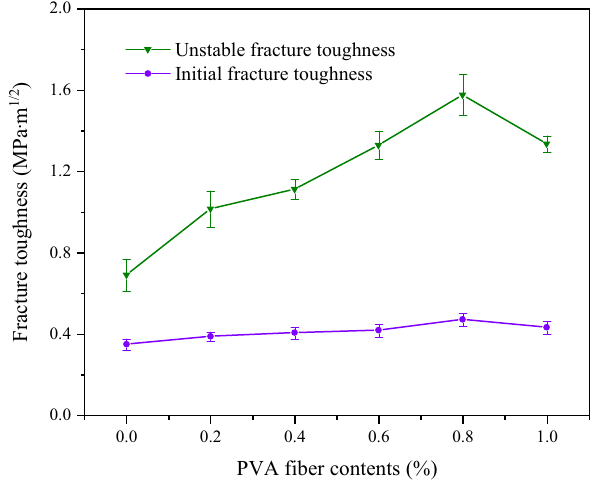
Figure 23: Fracture toughness versus PVA fi ber